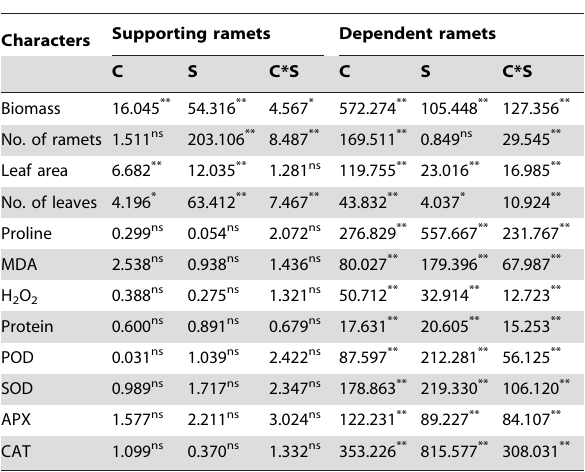
Table 2. F-values of two-way ANOVA which was used to test for the effects of contrast level of water availability (C), severance of stolon connection between the ramets (S) and their interaction (C*S) on the growth parameters and levels of stress indicators in supporting and dependent